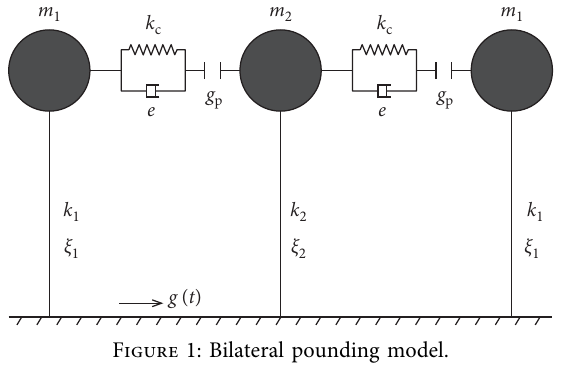
Figure 1: Bilateral pounding